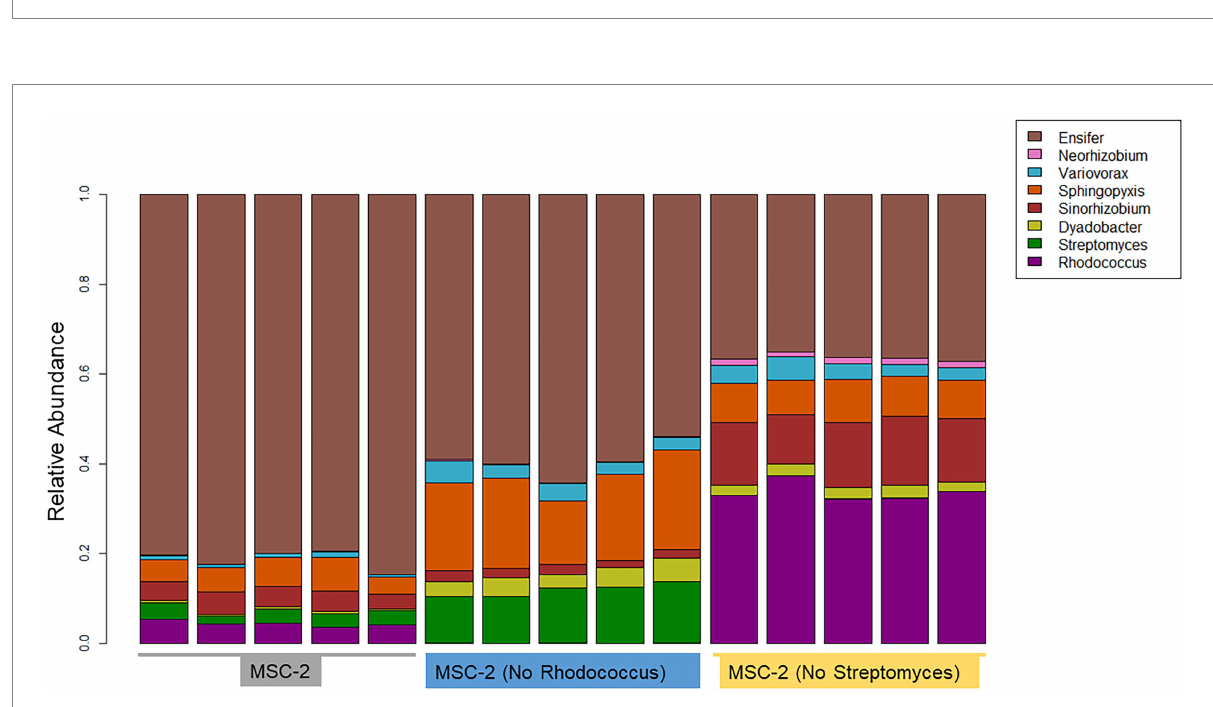
FIGURE 3 Taxonomic bar charts of MSC-2 members after chitin growth in MSC-2, MSC-2-R and MSC-2-S. Relative abundance is shown on the y-axis. MSC- 2, MSC-2-R and MSC-2-S communities are grouped together on the x -axis. Color scheme assigned to each species is shown on the upper